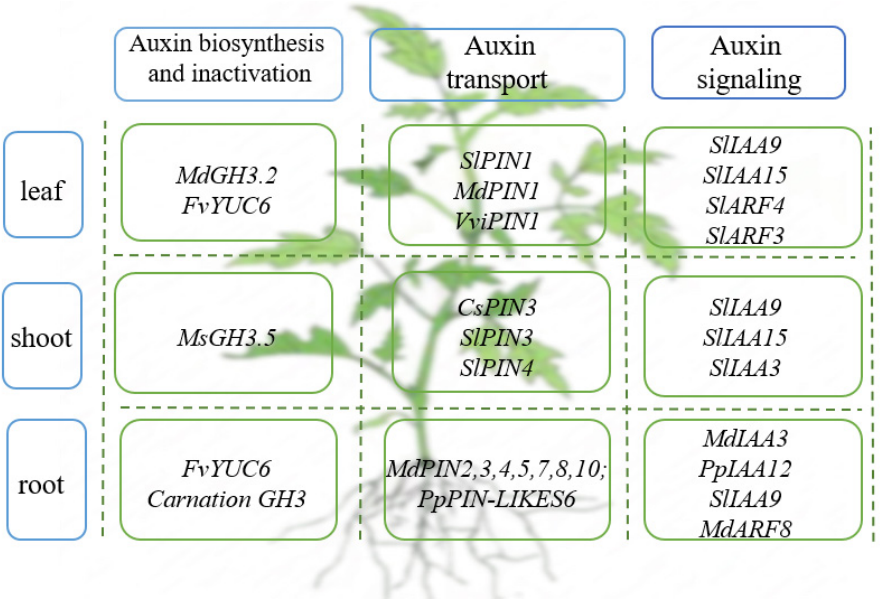
Figure 2. Auxin-related genes that play a role in the vegetative growth of horticultural